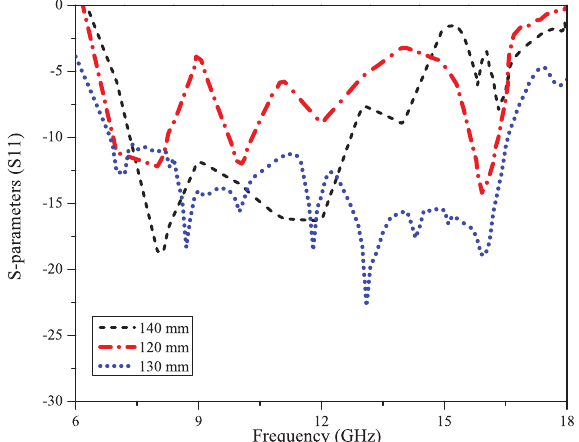
Figure 3. Variation of S-parameters with the length of the corrugated spoof surface plasmon polaritons (SSPP)